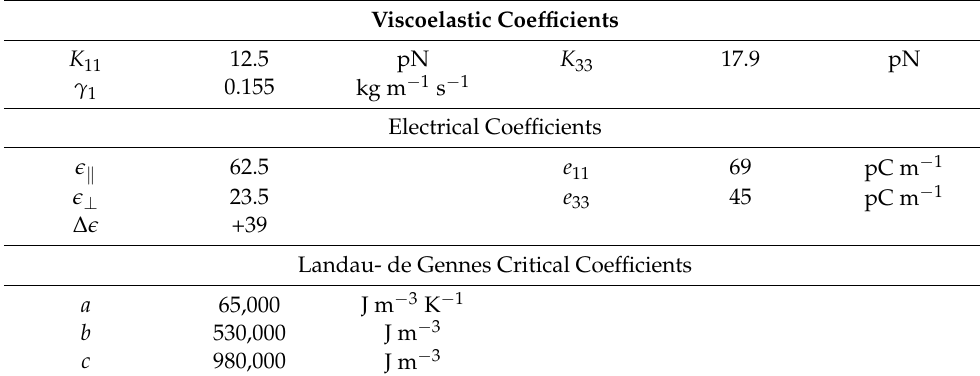
Table 2. Liquid crystal parameters used in the simulations